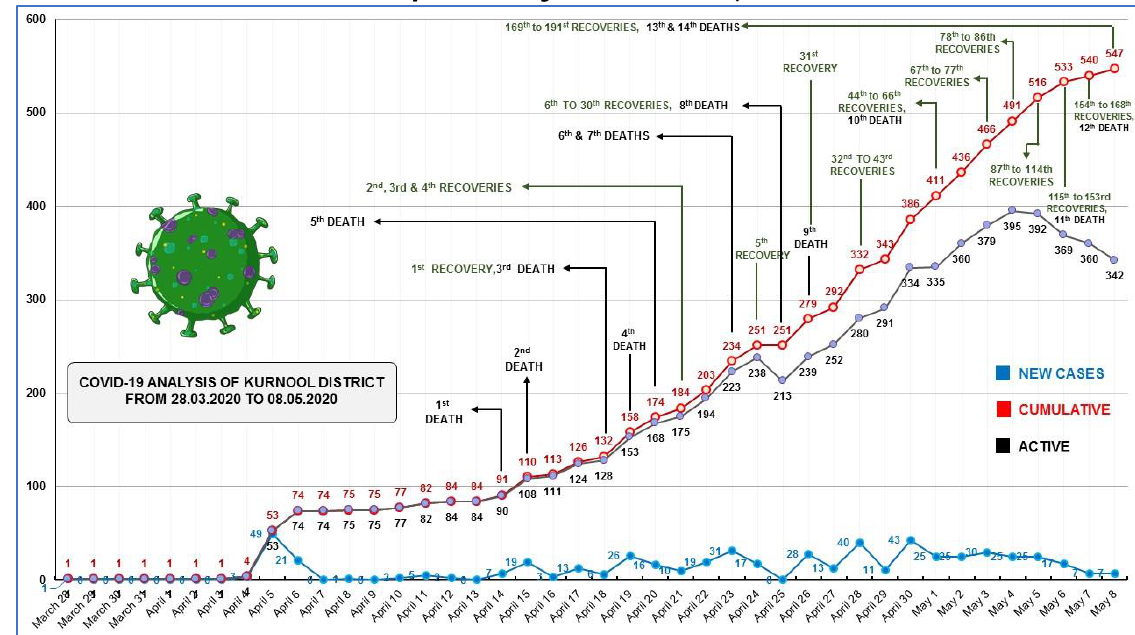
Figure 2. Graph representing temporal variation of new cases, cumulative cases and active cases from Kurnool District till May 5 th 2020 (Source: District